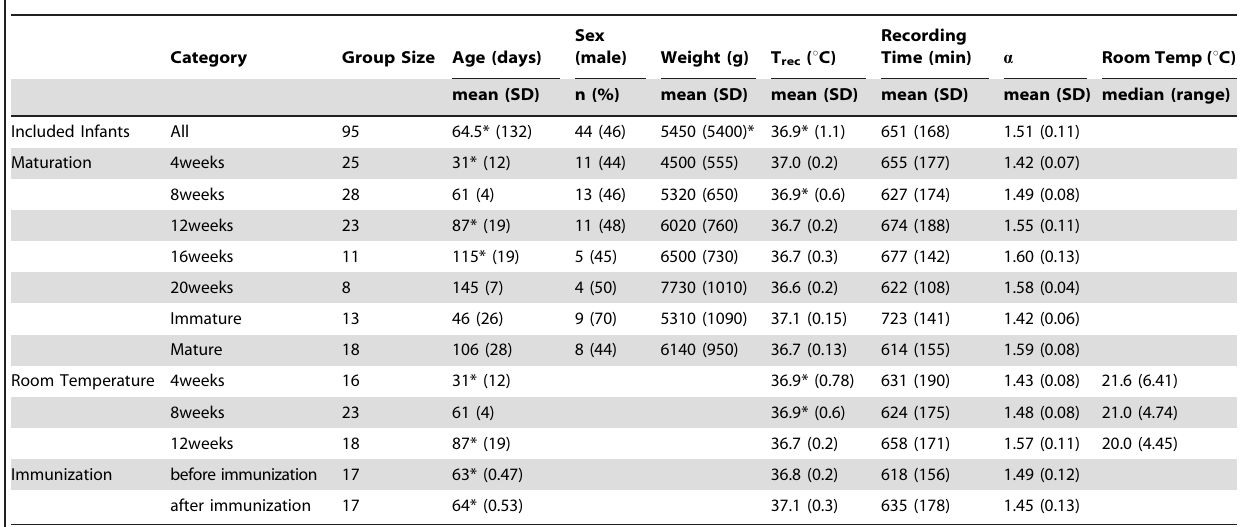
Table 1. Infant characteristics and changes in rectal temperature regulation with maturation, room temperature, and